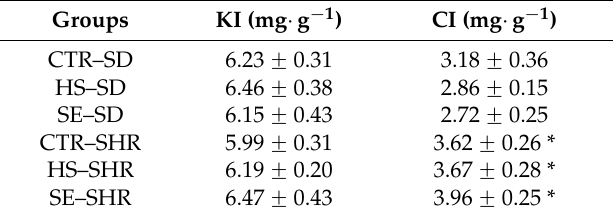
Table 1. Kidney index (kidney weight/body weight, KI) and cardiac index (heart weight/body weight, CI) were calculated after six weeks of treatment with Salicornia europaea extracts (SE) and high edible